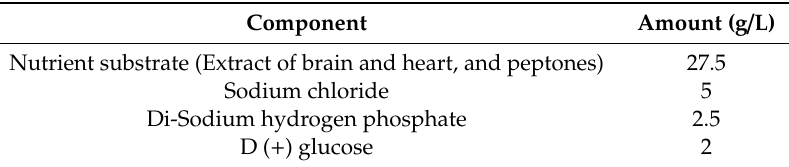
Table 1. Composition of commercial BHI